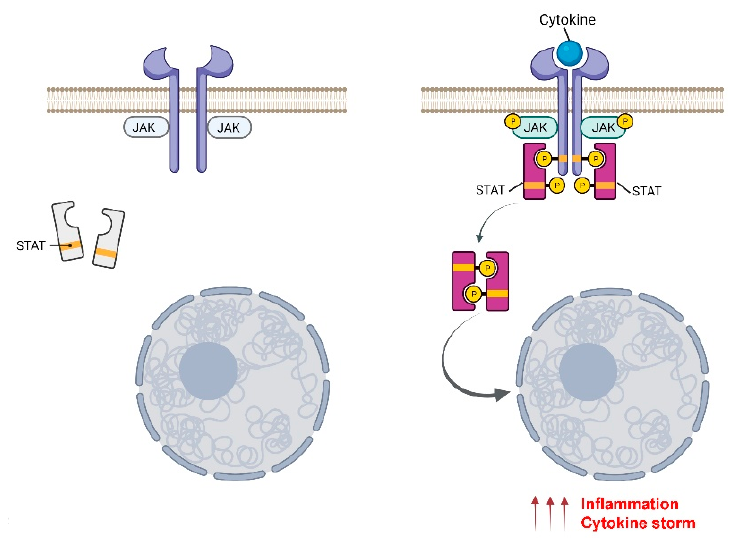
Figure 1. Schematic representation of JAK/STAT signal transduction pathway by cytokines. A cytokine binding to the receptor induces JAK activation and, consequently, STAT phosphorylation. Activated STATs form hetero- or homodimers that translocate to the nucleus and regulate the transcription of genes that cause hyperinflammation and cytokine storm. Created with BioRender.com (accessed on 16 March